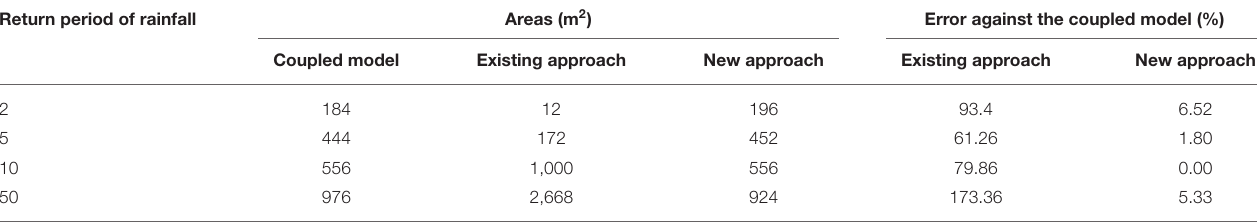
TABLE 3 | Final inundation area (8h) with the different approaches and the error vs. the coupled model. Return period of rainfall Areas (m 2 ) Error against the coupled model